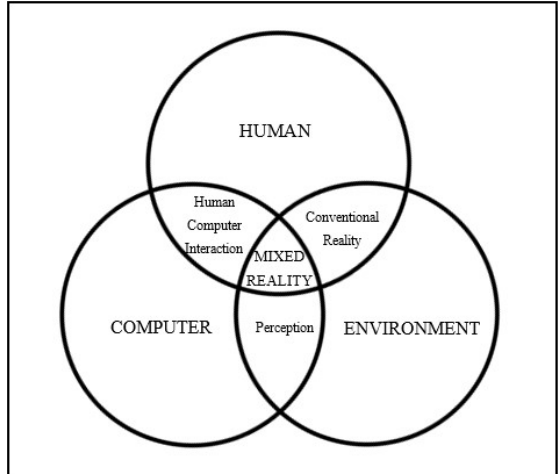
Fig. 1. The interference between computers, humans and environments.